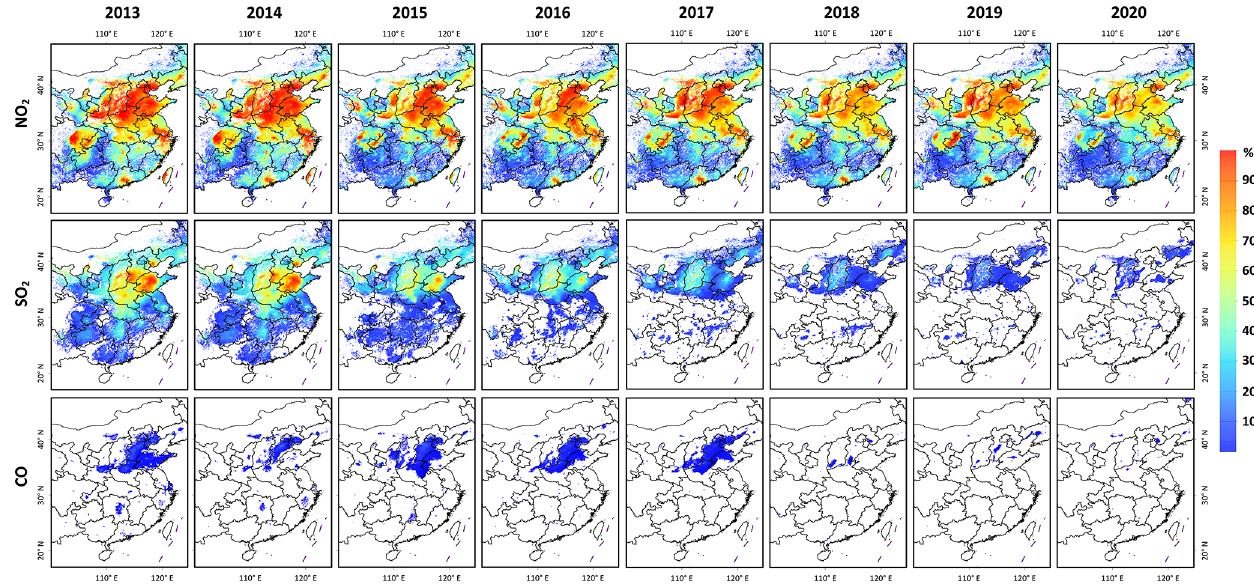
Figure 8. Spatial distributions of the percentage of days exceeding the WHO-recommended short-term desired air quality guidelines (AQG) level for surface NO 2 (daily mean > 25µgm − 3 ), SO 2 (daily mean > 40µgm − 3 ), and CO (daily mean > 4mgm − 3 ) for each year from 2013 to 2020 in populated areas of eastern